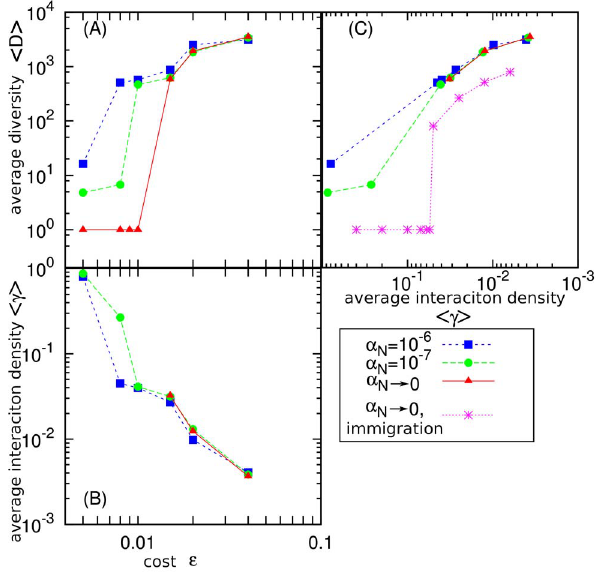
Figure 3. The long-time average of the systems behavior. (A) Diversity, S D T and (B) interaction density, S c T are shown as a function of E for a N ~ 10 { 6 , a N ~ 10 { 7 , and in the quasi-static simulation for a N ? 0 (the system size is L ~ 200 ). (C) The same data as in panels A and B plotted as S D T versus the measured interaction density S c T : Note that S c T decreases to the right. In the case of a N ~ 10 { 7 and in the quasi-static simulations we started from the high diversity state obtained for a N ~ 10 { 6 and E ~ 0 : 04 and simulated the relaxation to a constant value. For comparison, the results for the model without heredity, studied in Ref. [16], are also plotted in the quasi-static limit. For a smaller system size, e.g., L ~ 100 , the high diversity states shifts toward E? 1 as a N ? 0 , indicating that the high diversity state is not stable in the quasi-static limit for a too small system (data not